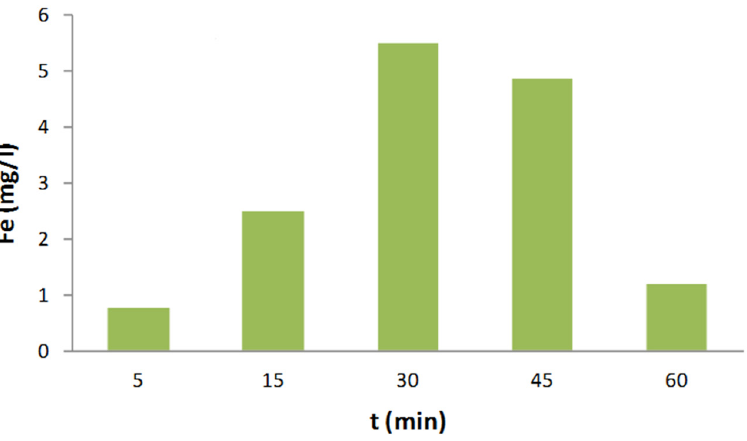
Figure 8. Leaching iron concentration after the applied optimized Fenton conditions within 60 min.